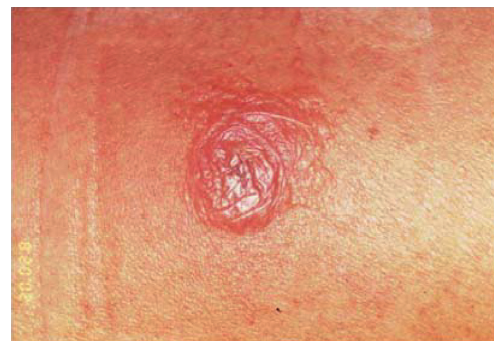
Figure 6: Positive Montenegro reaction (exacerbated).